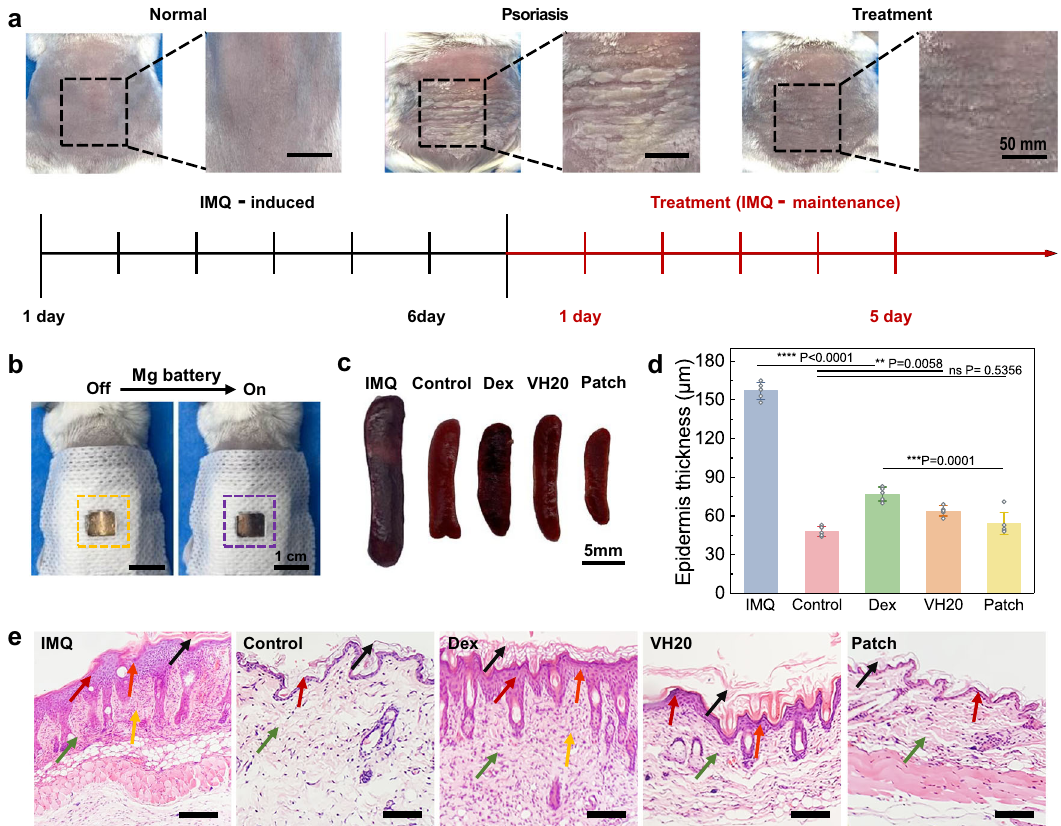
Fig. 6 | Wearable Mg battery-powered therapeutic devices for psoriasis mouse treatment. a Timeline and corresponding photos of normal skin, psoriasis model, and treatment process. b Color change of the Dex-loaded VH20 hydrogel during treatment;thedasharearepresentsthepatchsize. c Mousespleenphotographsfor IMQ-induced, and treated with Dex solution, Dex-loaded VH20 hydrogel, ionto- phoresis patch, normal model as the control. d Epidermis thickness of psoriasis mouse under different treatments. ( n =5 biologically independent animals). Data